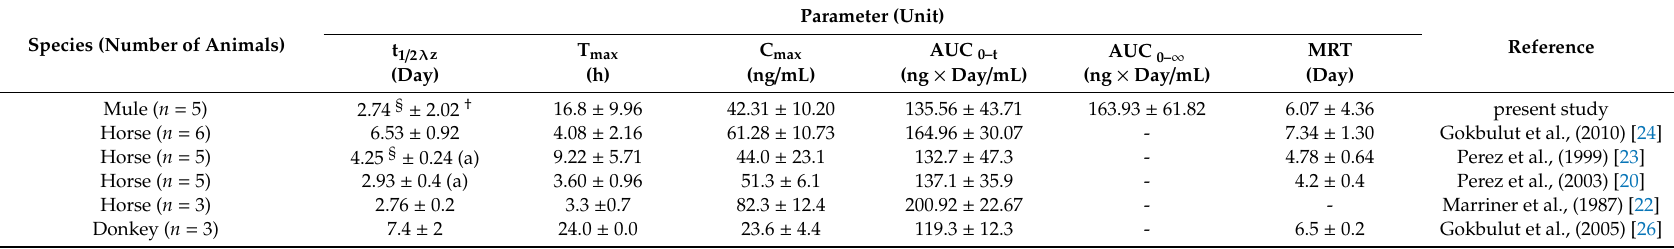
Table 2. Main pharmacokinetic parameters of ivermectin following oral administration at 200 µ g / kg BW in mule (present study), horse and donkey (derived from previous published